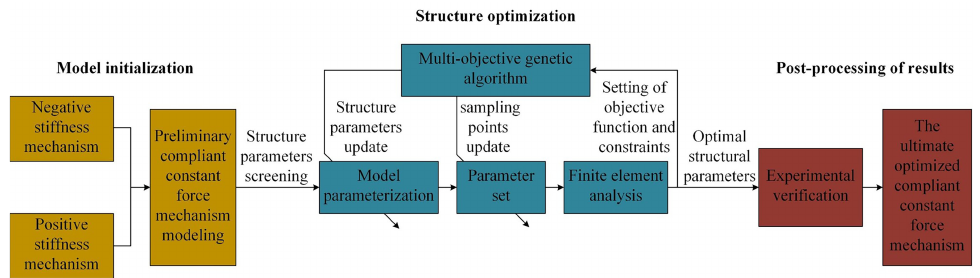
Figure 4. The optimization framework flow